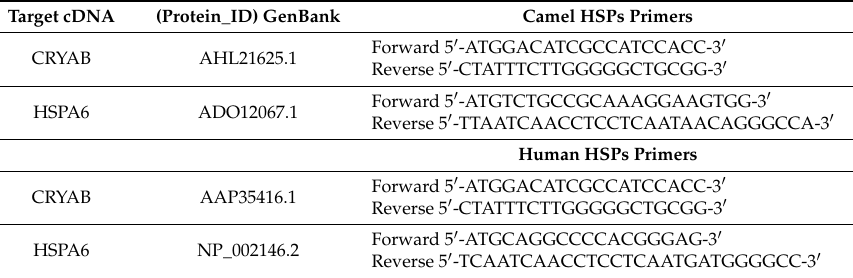
Table 2. Primers designed for specific amplification of the cDNAs of target camel and human